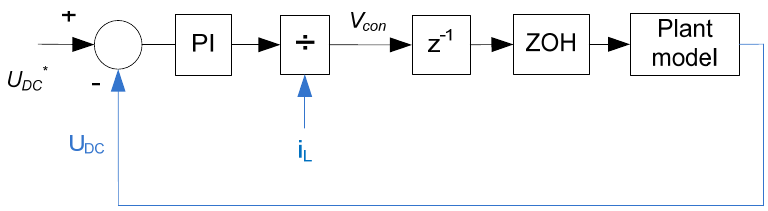
Figure 8. DC-link voltage controller connected to the